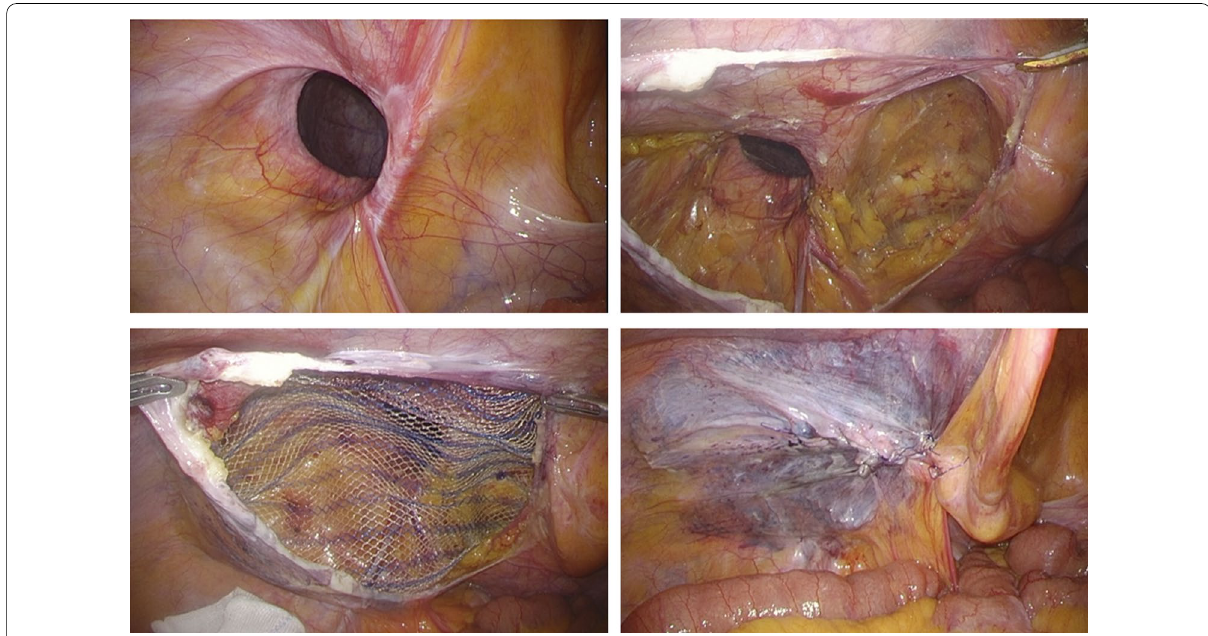
Fig. 2 Intraoperative findings during the first operation (laparoscopic transabdominal preperitoneal repair). Blood loss during the operation was